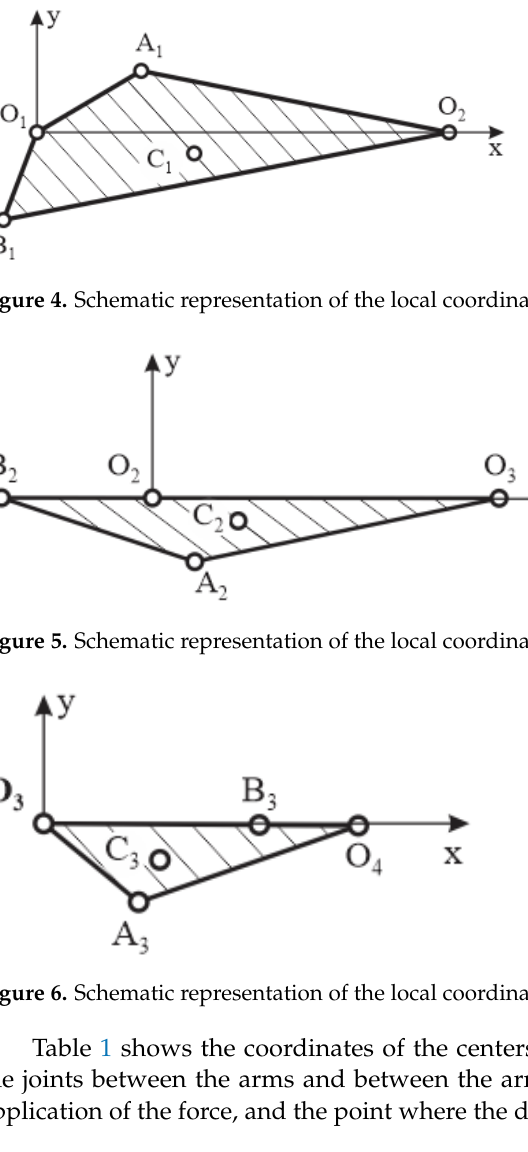
Table 1. Coordinates of points of interest in relation to the local coordinate systems. Arm No.